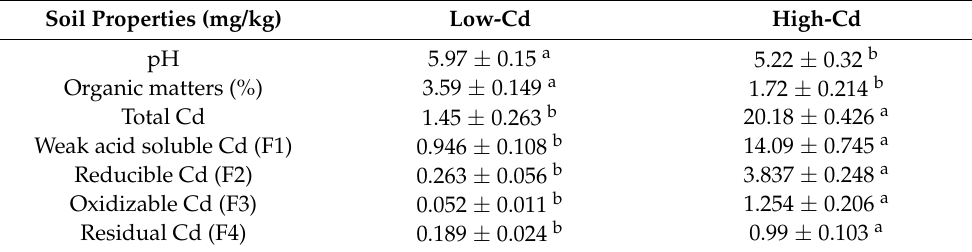
Table 1. The properties of soil samples from a high and low contaminated region. Soil Properties